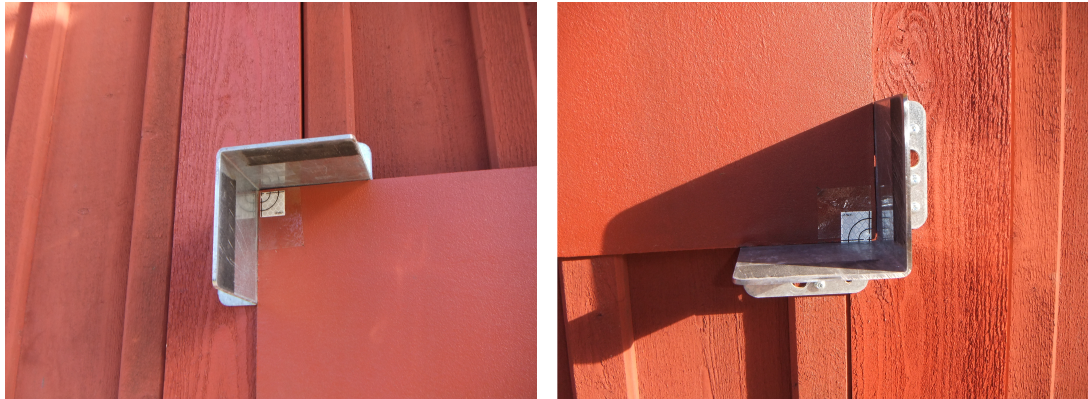
Figure 9. Metal stands at the top left and the bottom right corner of the working